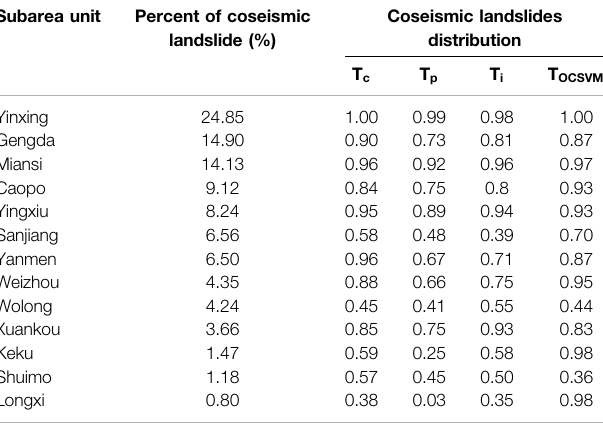
TABLE 4 | The percentage of coseismic landslides in the hazardous areas of towns and villages detected by the LSM using different negative data. Subarea unit Percent of coseismic landslide